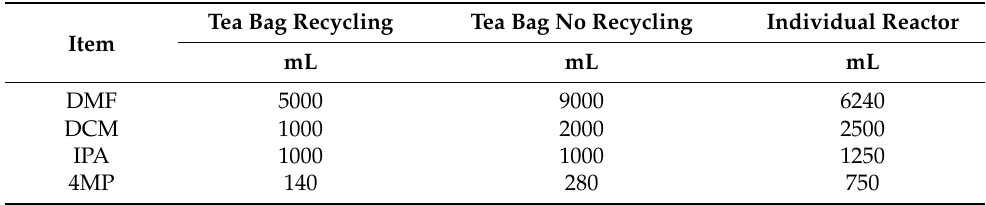
Table 4. Comparison of solvent consumption for synthesis with tea bags with and without recycling, and synthesis in an individual reactor. Tea Bag Recycling Tea Bag No Item